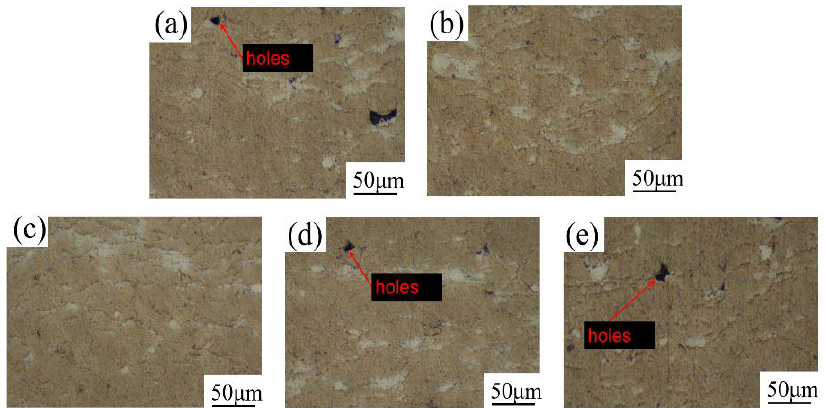
Figure 6. Microstructure of coating sections at different spraying speeds of powder-feeding motor: ( a ) 1.0 r/min, ( b ) 1.2 r/min, ( c ) 1.5 r/min, ( d ) 1.7 r/min, ( e ) 2.0 r/min.